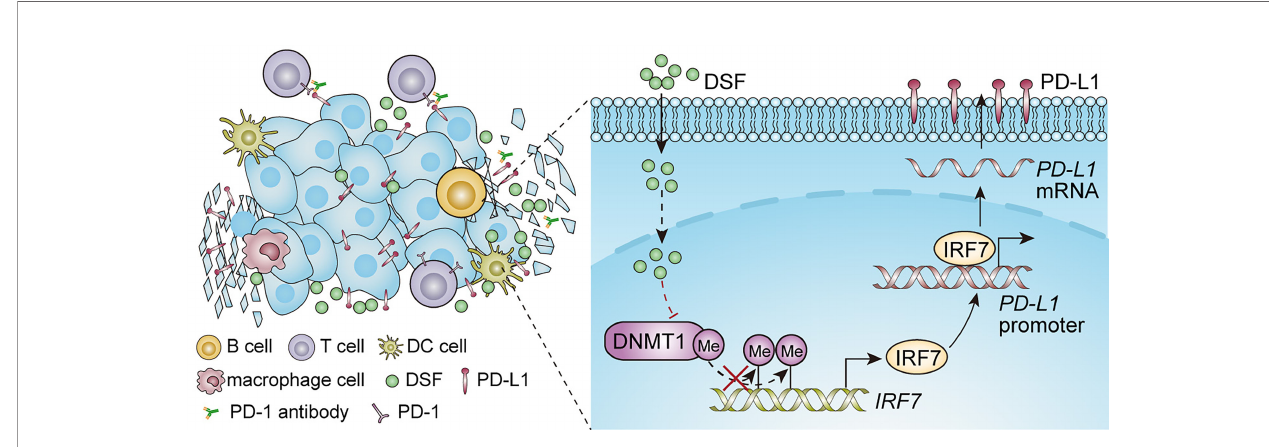
FIGURE 7 | An illustration of the proposed working model. Synergistic effect of DSF and PD-1 blocking antibody in the treatment of triple negative breast